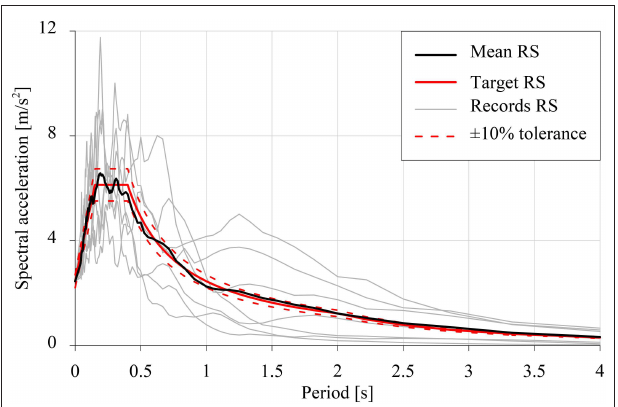
FIGURE 9 | Spectrum compatibility check